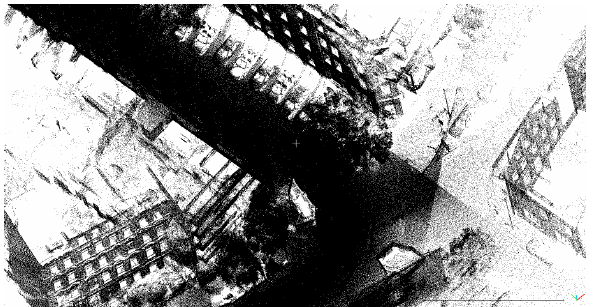
Figure 7. Map point cloud in LOD 2.